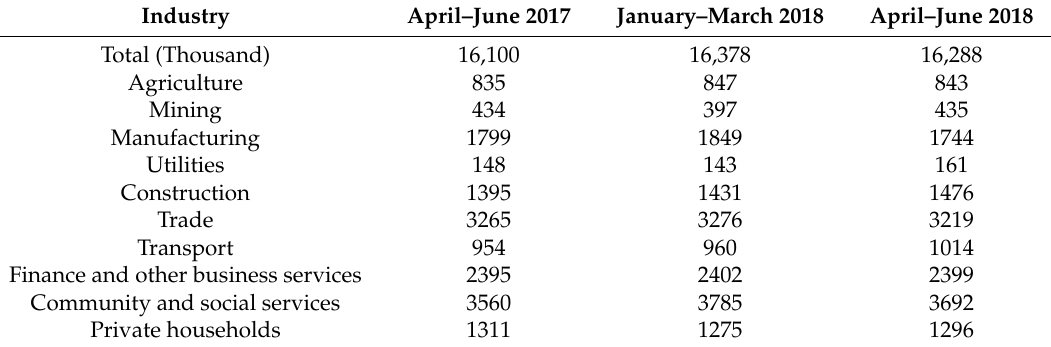
Table 1. A comparison of South African mining direct jobs creation compared to other sectors.